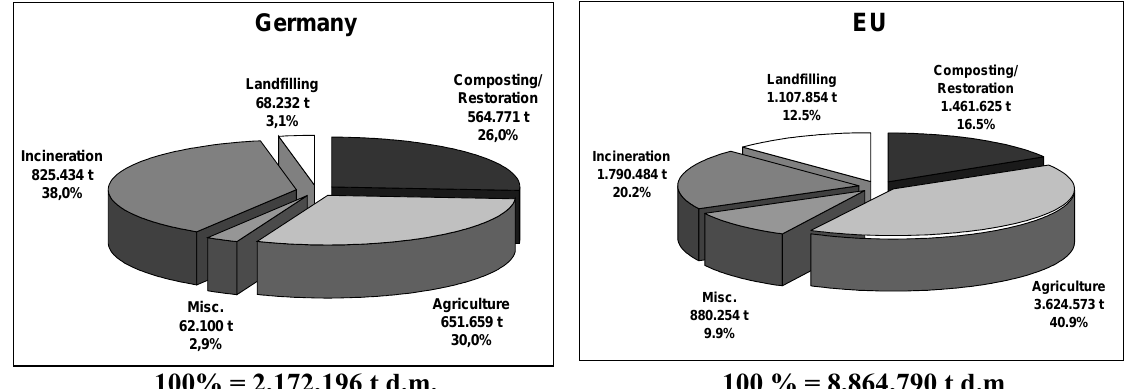
Figure 27: Sewage sludge generation and disposal in the EU and in Germany (Schmelz 2007) 3.62 million t d.m. of treated sludge from municipal waste water treatment can be seen as an alternative product to compost used in agriculture. In addition this is the case for 1.46 million t d.m. of sludge which is at least partly composted (exact figures on this proportion are missing) and mainly used for landscaping/land restoration